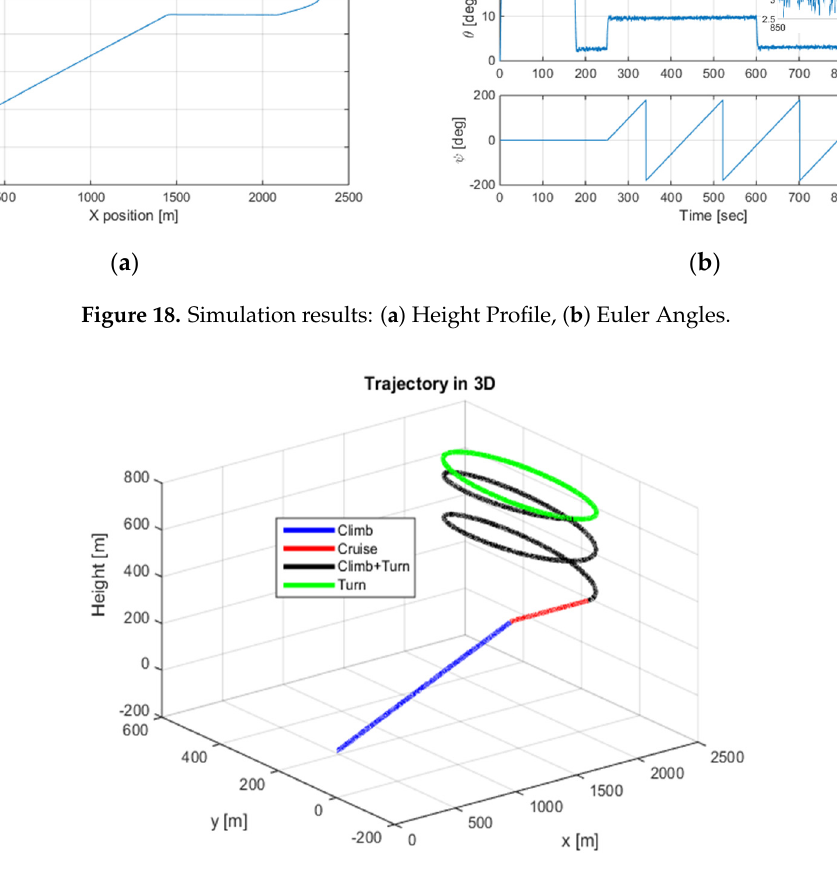
Figure 19. Solar UAV trajectory in 3D.